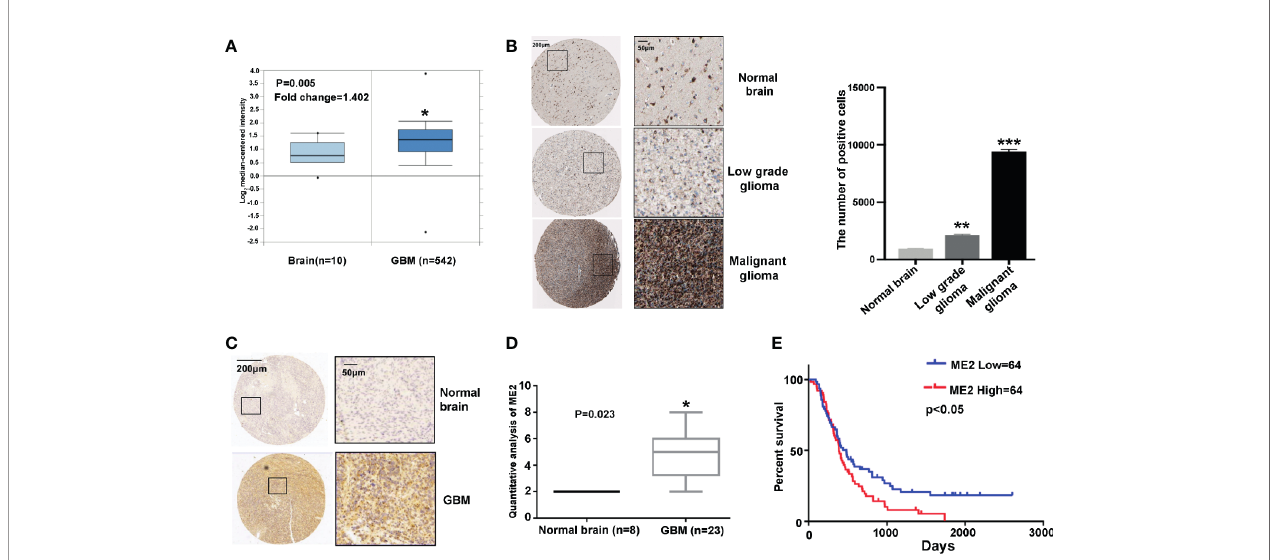
FIGURE 1 | ME2 expression is upregulated in GBM and associated with overall survival of patients. (A) mRNA levels of ME2 in GBM and normal brain tissues (*P < 0.05). (B) ME2 expression levels in different grades of glioma and statistics and analysis of positive cells results (**P < 0.01, ***P < 0.0001). (C) Immunohistochemical staining of ME2 in GBM and normal brain tissues. (D) Protein expression score statistics and analysis of staining immunohistochemical results (*P < 0.05). (E) Association of ME2 expression with overall survival of patients with GBM (cutoff for ME2 low/high=20.17, P =